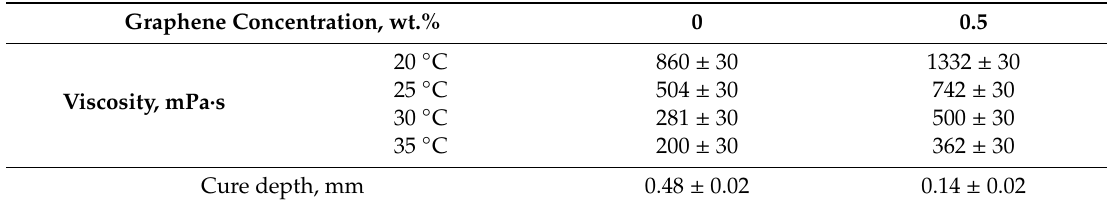
Table 1. The viscosity and cure depth of resin with or without graphene. Graphene Concentration, wt.%